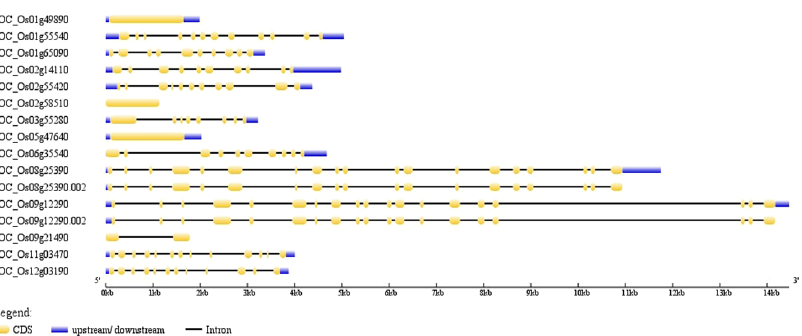
Figure 7. Gene organization of threonine encoding genes. The blue lines indicate the UTR regions, orange boxes indicate the exons and black lines show the